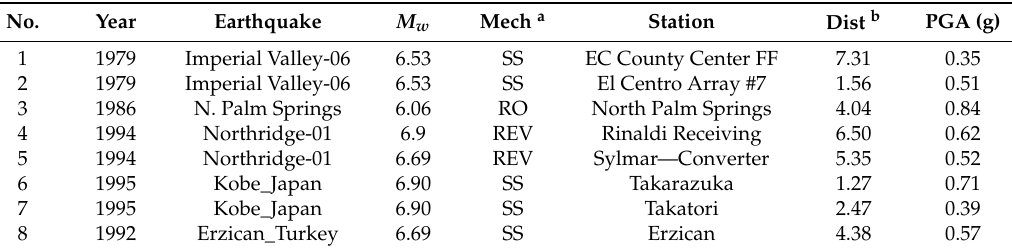
Table 2. Near field ground motion database.